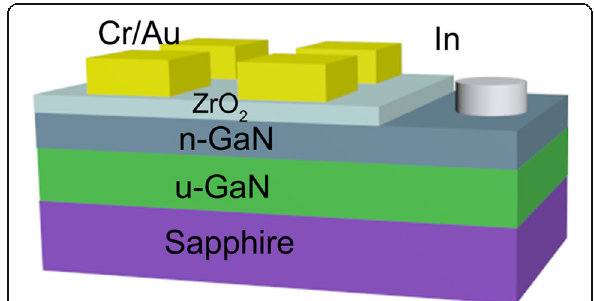
Fig. 1 The schematic diagram of Cr/Au/ZrO 2 /n-GaN MOS capacitors